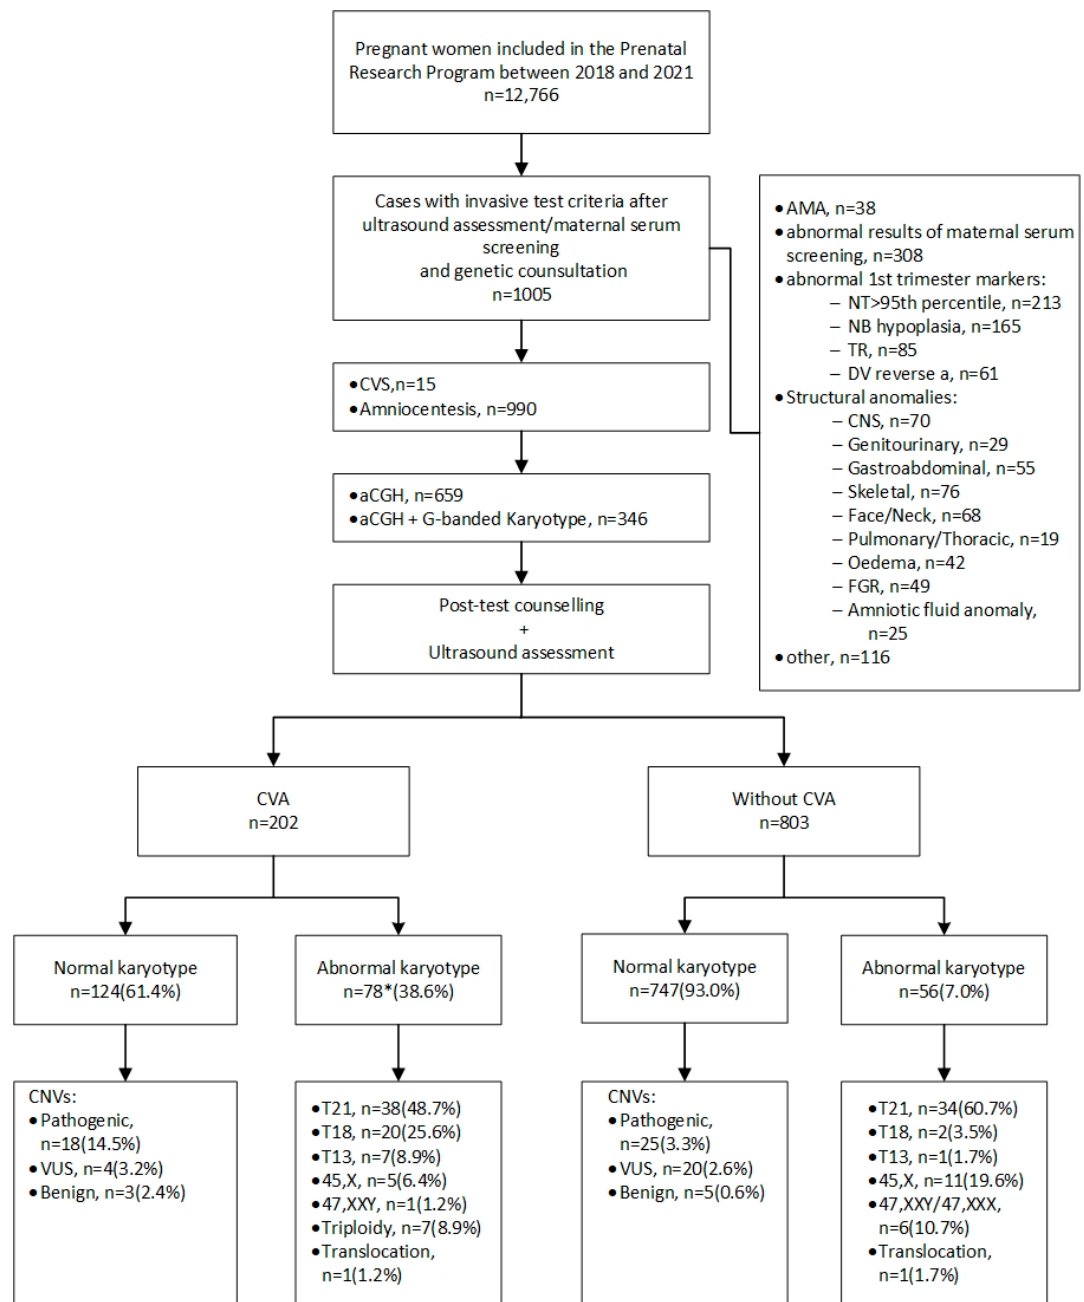
Figure 1. Flowchart showing genetic prenatal diagnosis in the Department of Obstetrics and Perinatology, Kraków, Poland. aCGH—array comparative genomic hybridization; AMA—advanced maternal age; CNS—central nervous system; CNVs—copy number variants; CVA—cardiovascular anomaly; CVS—chorionic villus sampling; DV—ductus venosus; NB—nasal bone; NT—nuchal translucency; TR—tricuspid regurgitation; T13—trisomy 13; T18—trisomy 18; T21—trisomy 21;